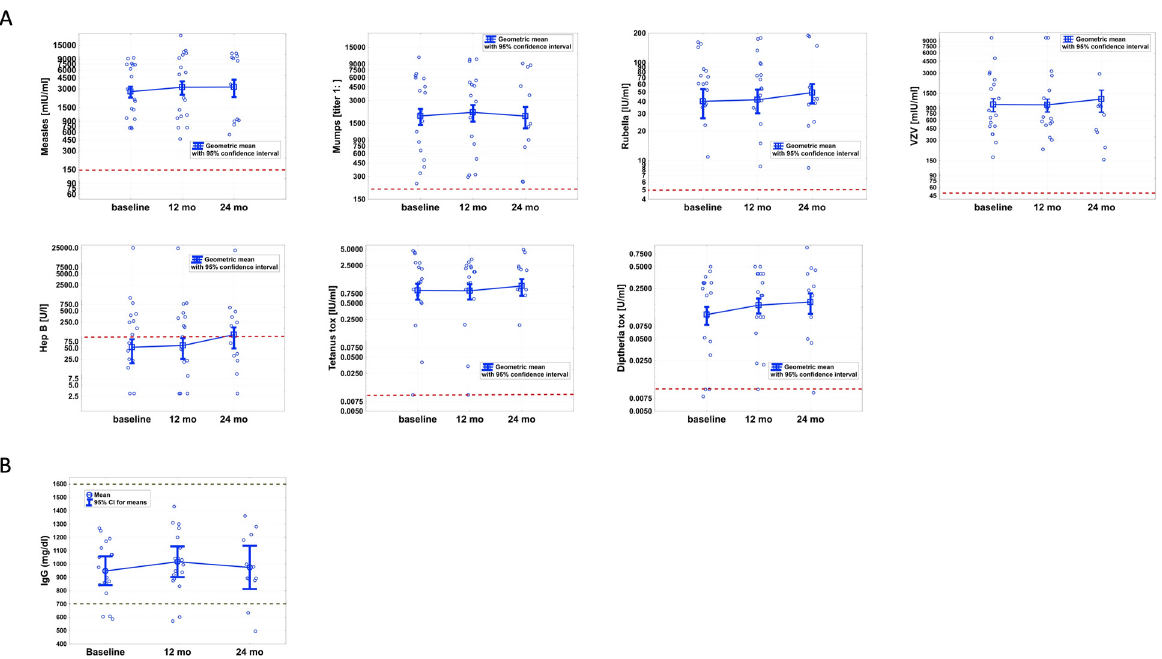
Figure 1. Specific IgG antibodies to 7 pathogens were not altered by cladribine (CLAD) treatment at 12 and 24 months (mo) ( A ). Absolute IgG blood levels remained stable despite immune reconstitution by CLAD ( B ). No significant reductions were found. CLAD tablets were administered at baseline and months 1, 12 and 13 according to the manufacturer’s recommendations. Red dotted lines indicate the cut-offs for antibody titers. Black dotted lines represent the normal range.